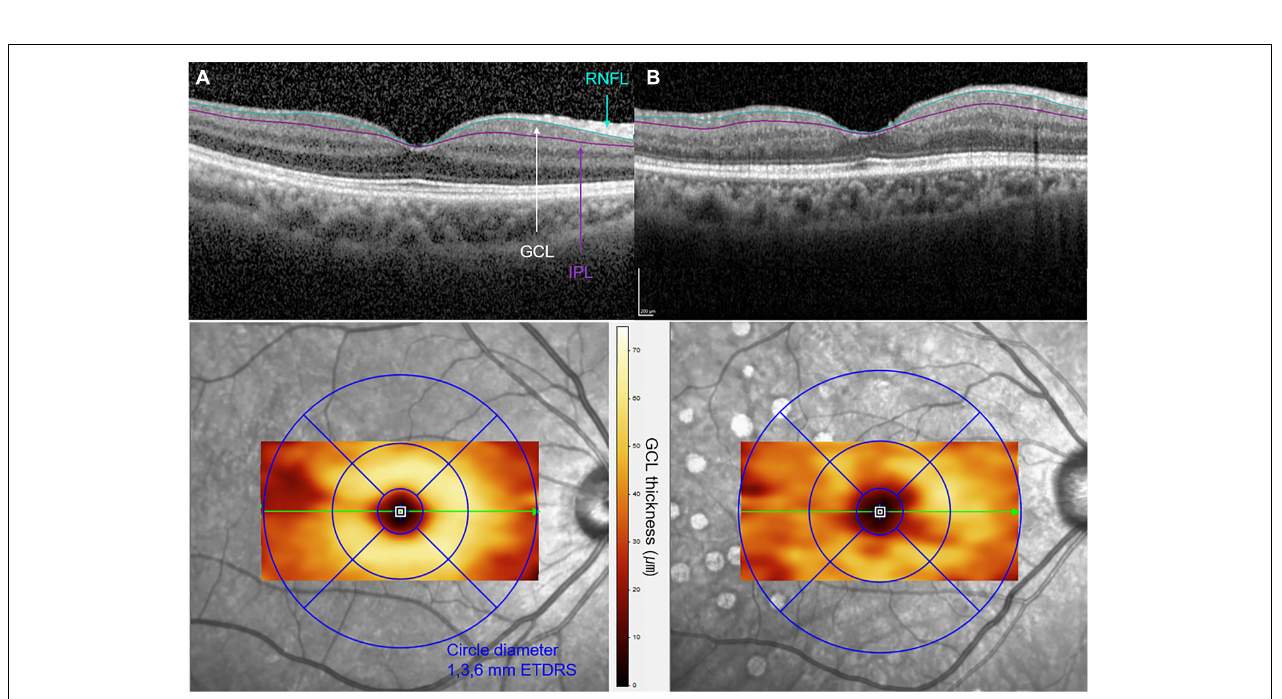
FIGURE 2 | Optical coherence tomographic (OCT) images of (A) a 62-year-old female with non-proliferative DR and of (B) a 63-year-old female with proliferative DR. A cross-sectional B-scan of foveal center within the 6 × 6-mm macular cubes is shown in the upper row. The segmentation lines on the B-scan represent the inner retinal nerve fiber layer (RNFL) and outer inner plexiform layer (IPL) boundaries of the slab of ganglion cell layer (GCL). The increased irregularity of the GCL boundaries is observed in (B) when compared to (A) . En-face OCT image with color topography of each GCL thickness corresponding to the Early Treatment Diabetic Retinopathy Study (ETDRS) circles is presented in the bottom row. A decrease in GCL thickness is presented in panel B compared to panel A, as a significant color change in the 1- to 3-mm perifoveal zone.